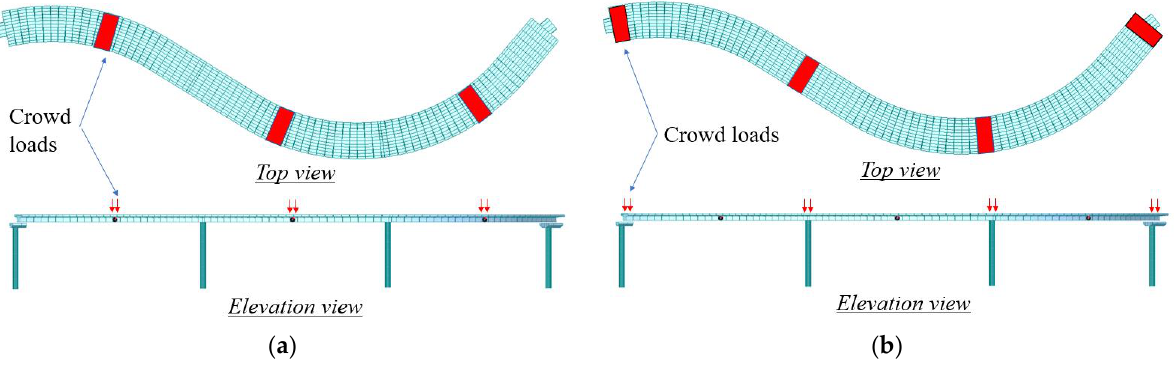
Figure 7. Depiction of the two load cases of in-situ tests of the bridge instrumented with three mass tuned dampers: ( a ) Case I and ( b ) Case II. A red area represents 10 adults, with an average weight of 750 n per person and distributed at 0.6 of a person per m 2 .